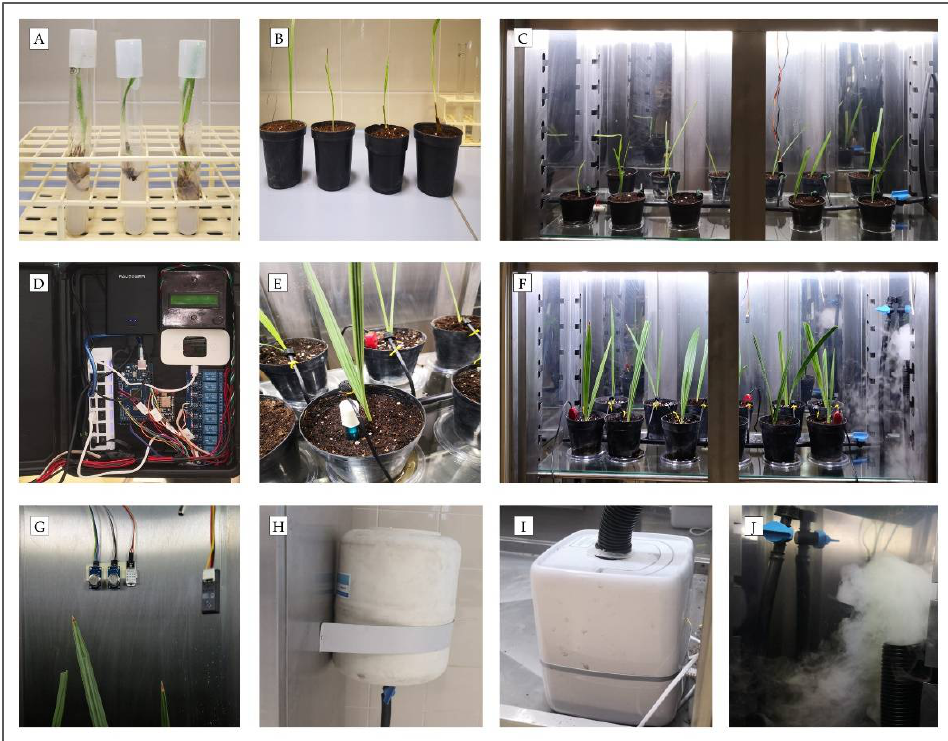
Figure 6. The experimental setup of TCPs for acclimatization in the E-VAS chamber. ( A ) In vitro plantlets, ( B ) Ex vitro plantlets, ( C ) Plants after the first week of transfer into the E-VAS chamber, ( D ) Hardware for monitoring and controlling the automated system, ( E ) Soil moisture content and soil pH sensors, ( F ) Plantlets after six months, ( G ) RH, temperature, and air quality sensors, ( H ) Water tank, ( I ) The ultrasonic humidifier, and ( J ) Outputted mist.